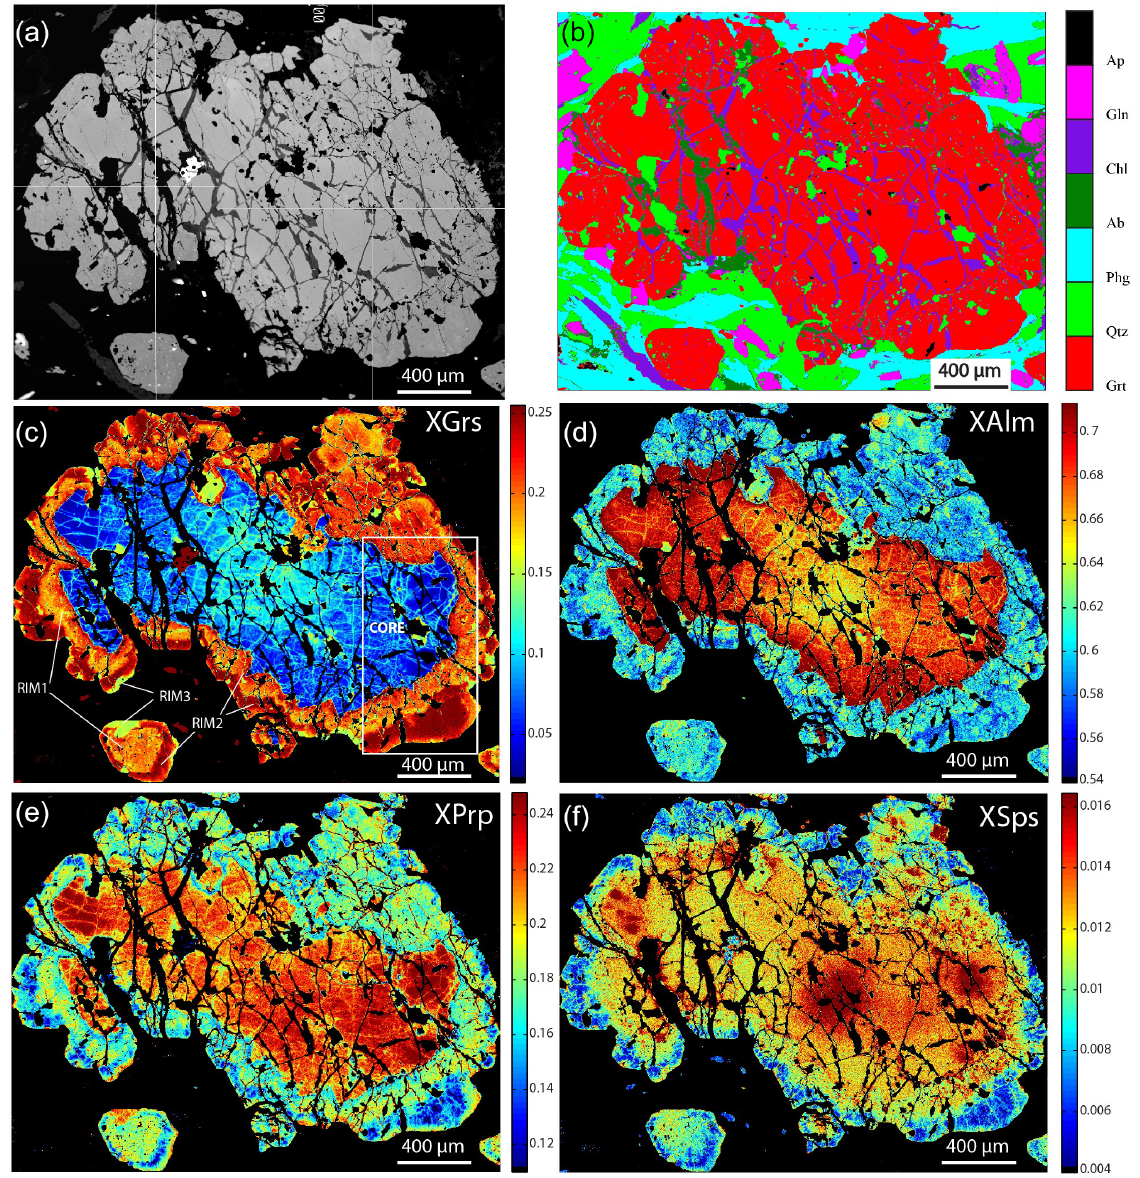
Figure 6. Large garnet (ø ∼ 2–3mm) in sample FG12157. (a) BSE picture with a bright porphyroclastic core and a darker rim. (b) Mineral phases (based on X-ray maps). Quartz inclusions are present in several garnet growth zones, but locally mark the core–Rim1 boundary; note that fractures (filled by chlorite and albite) dissect the entire garnet grain. Glaucophane and phengite seem to be intergrown with garnet Rim2. (c) Standardized X-ray map for the X Grs endmember (the white rectangle indicates the location of Fig. 3b–c). Note the lobate edges along the core and the fracture network within the core that is sealed by garnet higher in X Grs . Zoning patterns in small garnet crystals are similar. (d, e) Standardized X-ray maps for X Alm and X Prp display zoning inside the core. (f) Standardized X-ray map for X Sps . The image appears fuzzy because Mn contents are low. Note the areas with higher X Sps in the